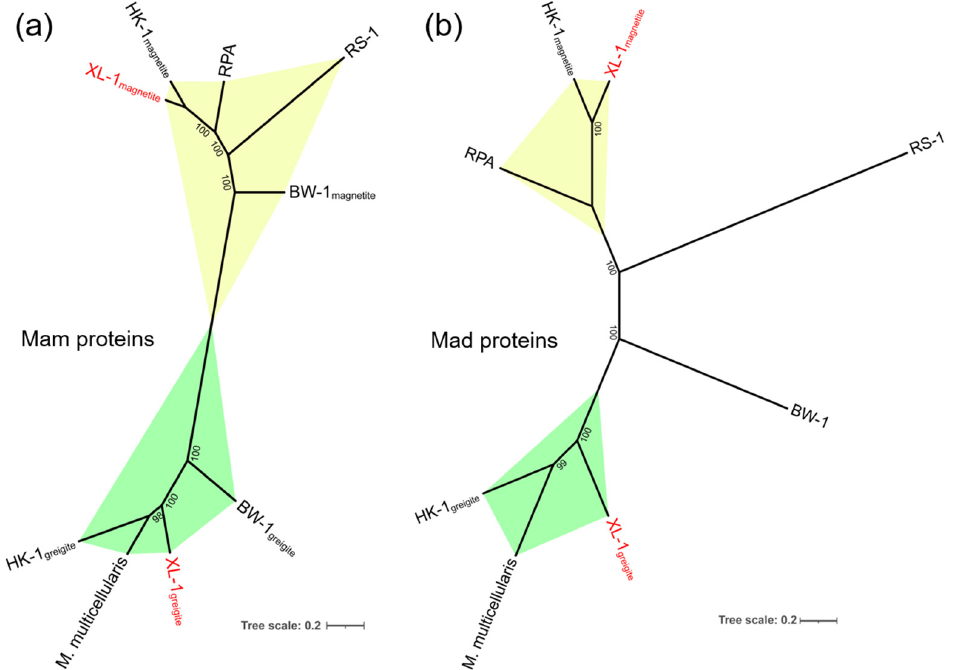
Figure 6. Phylogenetic tree based on ( a ) seven concatenated magnetosome membrane protein se- quences (MamA*B*E-Cter*E-Nter*I*K*Q) and ( b ) five concatenated magnetosome-associated Deltapro- teobacteria protein sequences (Mad23*24*25*26*27) that reflect the evolution of magnetotaxis. The trees were constructed using the maximum likelihood method, using IQ-TREE software. Bootstrap values were calculated using 1000 replicates. The scale bar represented 20% sequence divergence. Six strains were chosen, including Ca. Magnetomorum (HK-1), Ca. Magnetananas rongchenensis (RPA), Desulfovibrio magneticus (RS-1), Desulfamplus magnetomortis (BW-1), Ca. Magnetoglobus multicellularis ( M. multicellularis ), and MMP (XL-1) (acquired in this study and shown in red). The proteins involved in magnetite and greigite biomineralization are shown in the yellow and green regions, respectively.